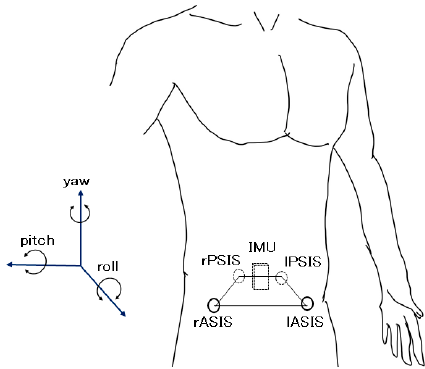
Figure 1. Positions and coordinate system of the inertial measurement unit (IMU) and mocap markers. Pelvic orientation angles from the mocap were calculated with four markers according to previous studies [1,13,14]. Pelvic obliquity (roll) and rotation (yaw) were calculated as tilts of left and right ASIS markers towards the horizontal line and the runway. Anterior–posterior tilt (pitch) was obtained as an angle formed by a vertical plane and the plane defined by ASIS markers and a